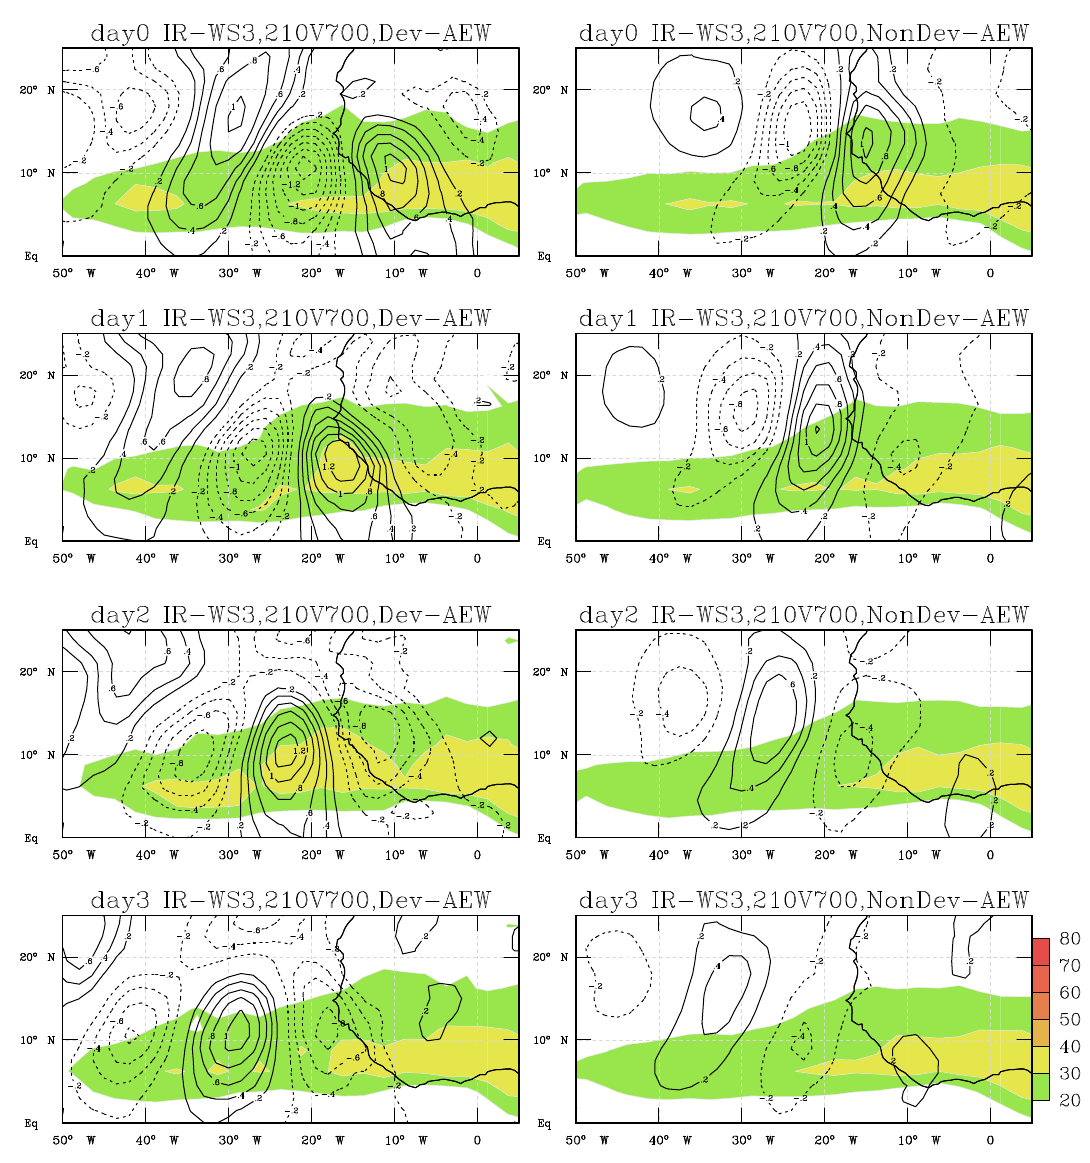
Figure 7. Composite of frequency of IR-WS3 (smaller scale less well-organized deep convection) and 2–10 day filtered 700 hPa meridional wind for developing AEWs and for non-developing AEWs. IR-WS3 is shaded in color bars every 10%. Composites based on developing AEW events are presented on the left, while composites based on the non-developing AEWs are on the right side. Meridional winds are contoured every 0.2 m/s.